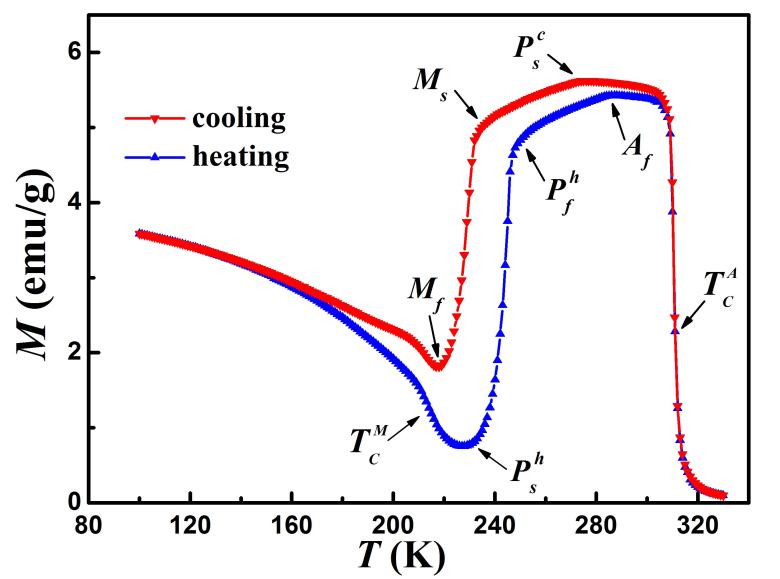
Temperature dependence of magnetization M (T) for the Ni50Mn34In15.5Al0.5 alloy measured upon cooling and heating with magnetic field of 100 Oe.